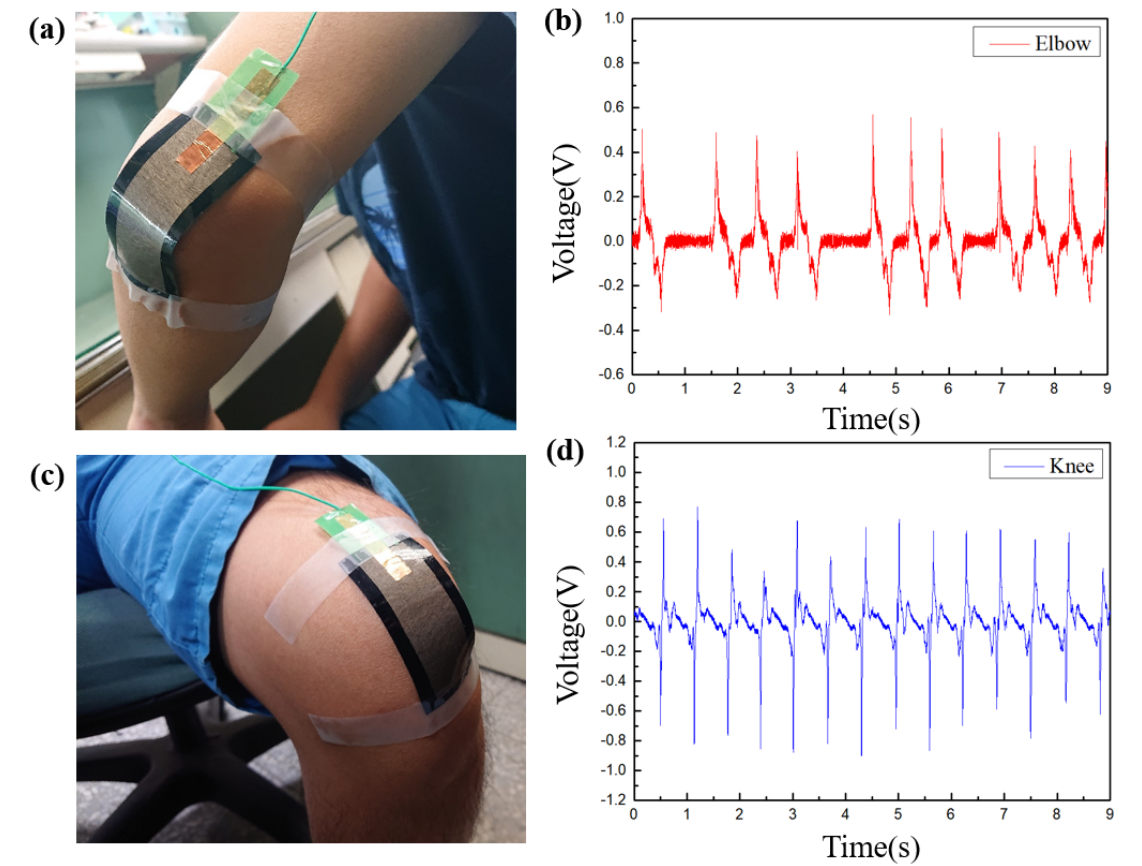
Figure 10. The electric signal of human body motion captured by MN-FTENG, ( a , b )the voltage of the elbow motion signal captured by MN-FTENG reaches 0.6 V; ( c , d ) The knee joint reaches 0.8 V. With the result of Figure 9, it also shows the force of squeezing MN-FTENG during elbow bending and knee bending is about 0.05 N and 0.1 N by extrapolation.